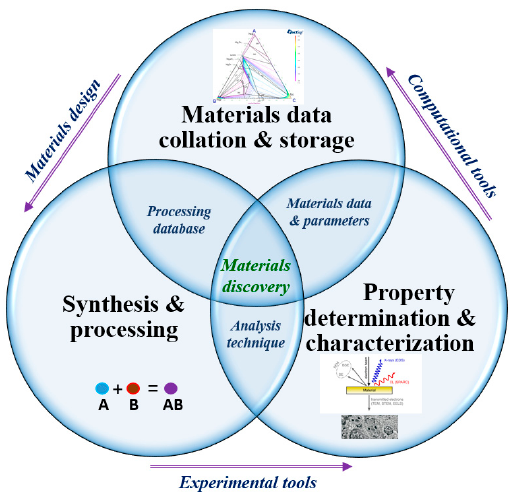
Figure 1. A diagram showing the relationship between materials design, experimentation, and mod- eling in a framework for the discovery of new inorganic